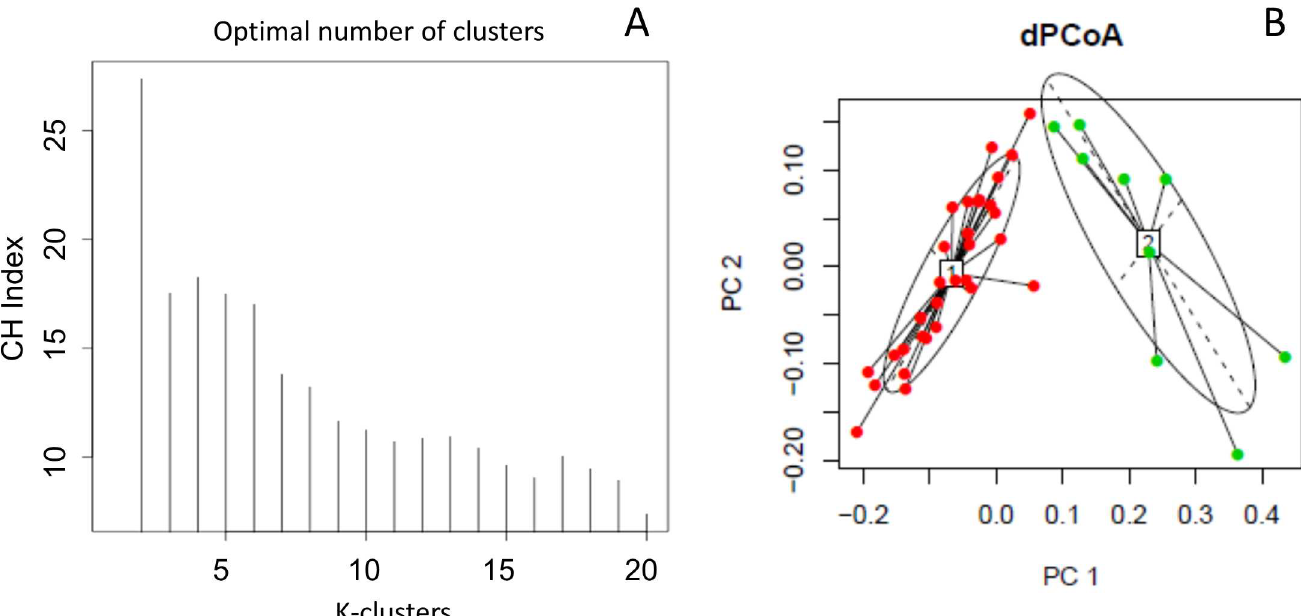
Fig 4. Enterotype classification A) k refers to clusteringusing the Calinski-Harabaszindex B) PcoA plots using the Jensen-Shannondistance.